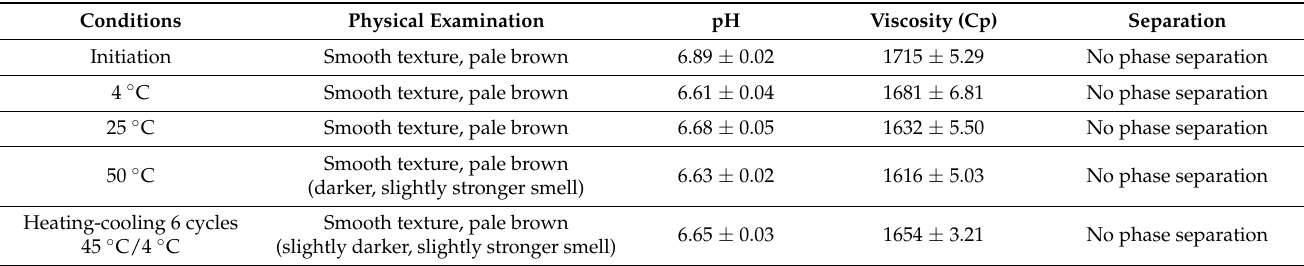
Table 9. The physical stability of the anti-cellulite emgel at initiation day and after being stored at 4 ◦ C, 25 ◦ C, and 50 ◦ C for 3 months and after 6 heating-cooling